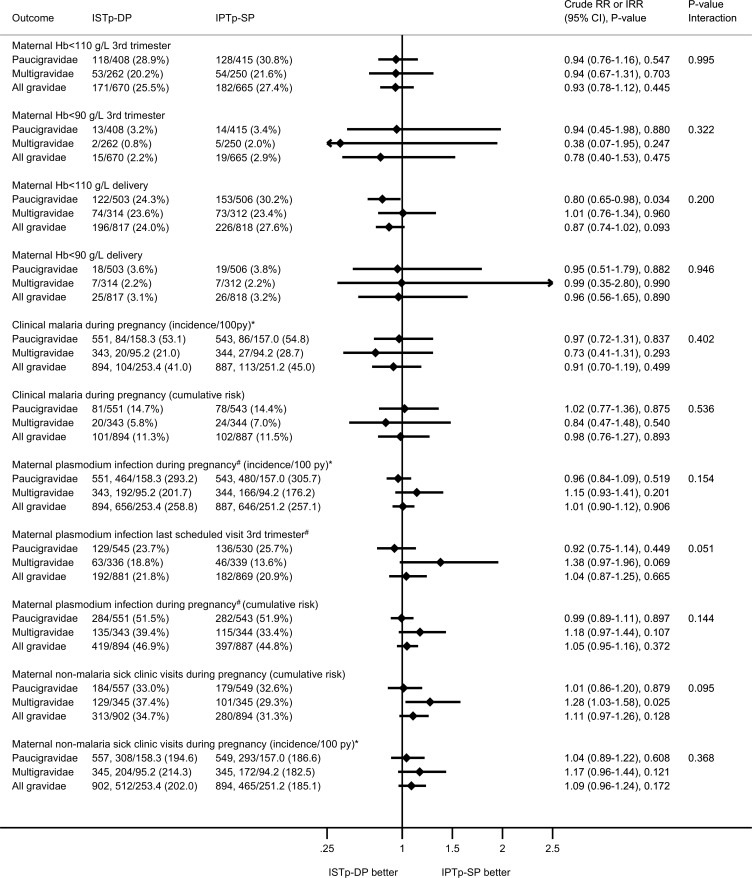
Secondary maternal outcomes: anemia and malaria.The p-value for the interaction term depicts the p-value for differences in effect size between paucigravidae and multigravidae.*Data given as the number of women with an event, the number of events/person-years of follow-up, and, in parentheses, the incidence rate per 100 person-years.
#Maternal plasmodium infection detected by PCR, microscopy, or RDT. RDT data considered only when women were symptomatic (febrile). To allow for comparison between study arms, the routine scheduled RDT data in the ISTp-DP arm were not included.Hb, hemoglobin; IPTp-SP, intermittent preventive therapy in pregnancy with sulfadoxine-pyrimethamine; IRR, incidence rate ratio; ISTp-DP, intermittent screening and treatment in pregnancy with dihydroartemisinin-piperaquine; py, person-years; RR, relative risk.